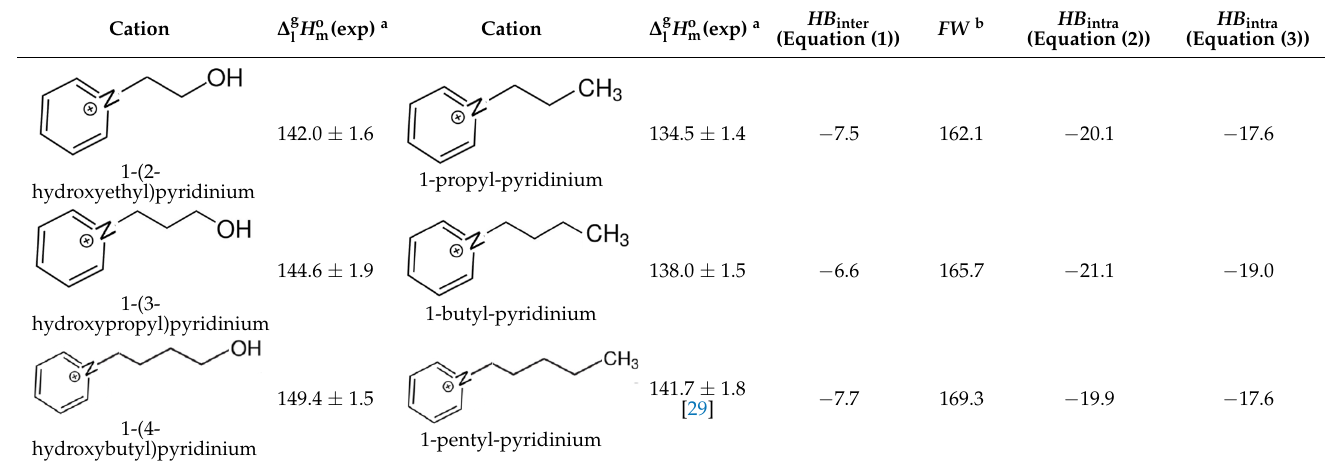
Table 5. Experimental enthalpies of vaporisation of hydroxyl-alkyl-pyridinium [NTf 2 ] and alkyl- pyridinium [NTf 2 ] and the strength of inter- and intra-HB calculated from these values (at 298 K, in kJ · mol − 1 ). a Experimental data from Table 4. b Enthalpies of vaporisation referred to the frameworks (see text).